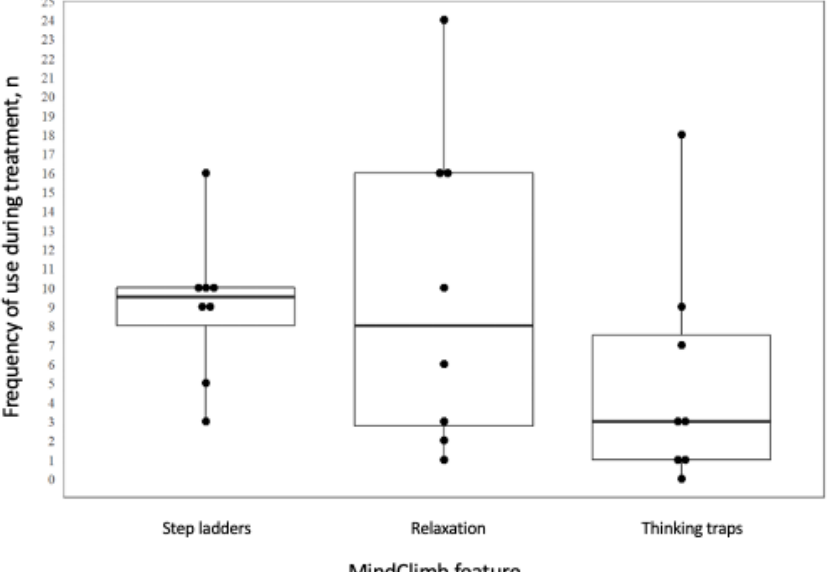
Figure 7. Median use of MindClimb features over 7 sessions of group cognitive behavioral